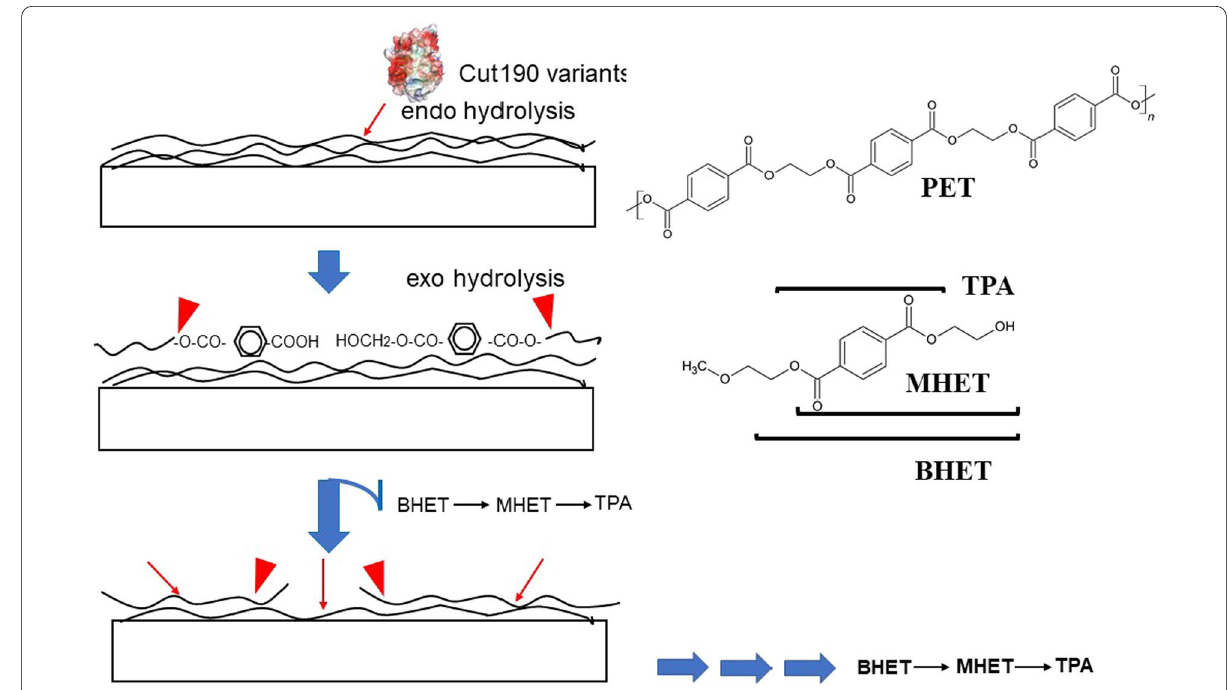
Fig. 6 Concerted depolymerization process by endo-type and exo-type